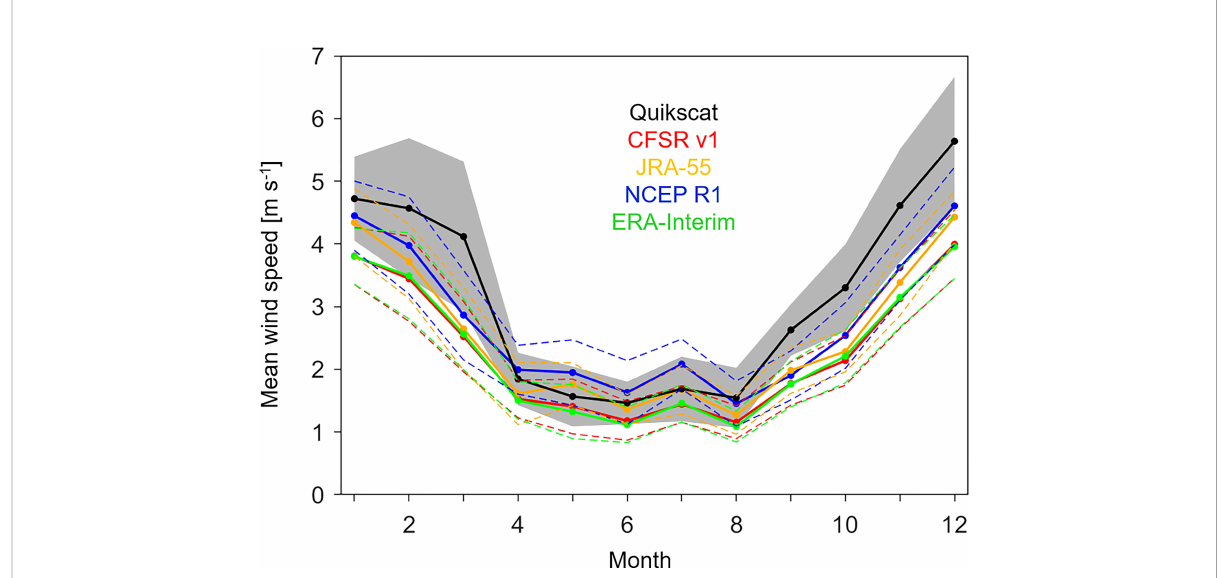
FIGURE 14 Annual cycle of monthly mean wind speed over the Japan Sea for the observations (black), CFSR v1 (red), JRA-55 (yellow), NECP R1 (blue), and ERA-Interim (green). The solid lines indicate the monthly mean and the shading indicates ±1 standard